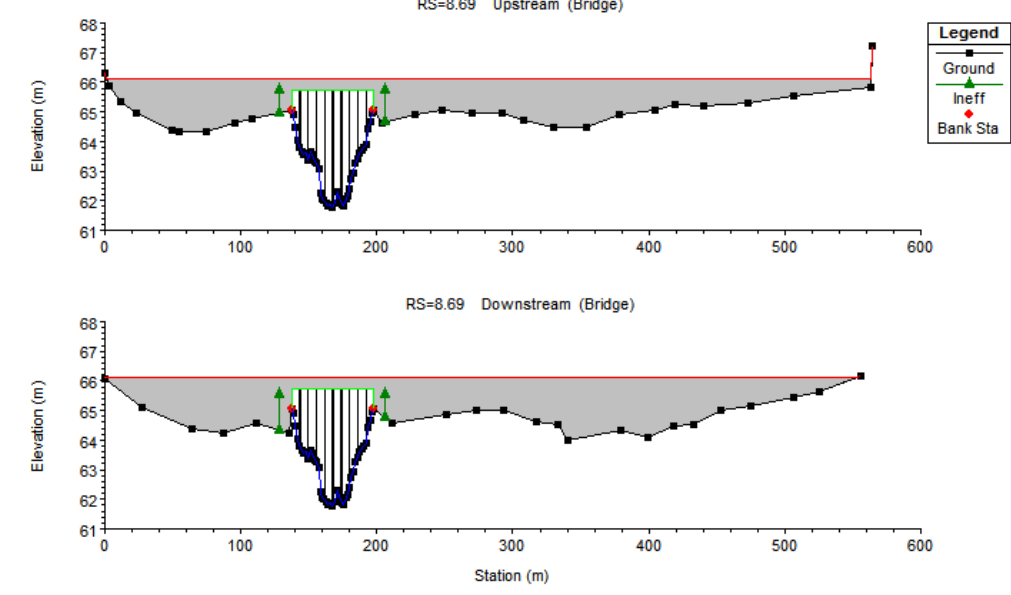
Figure 3. Bridge structure on Highway 1049 located at